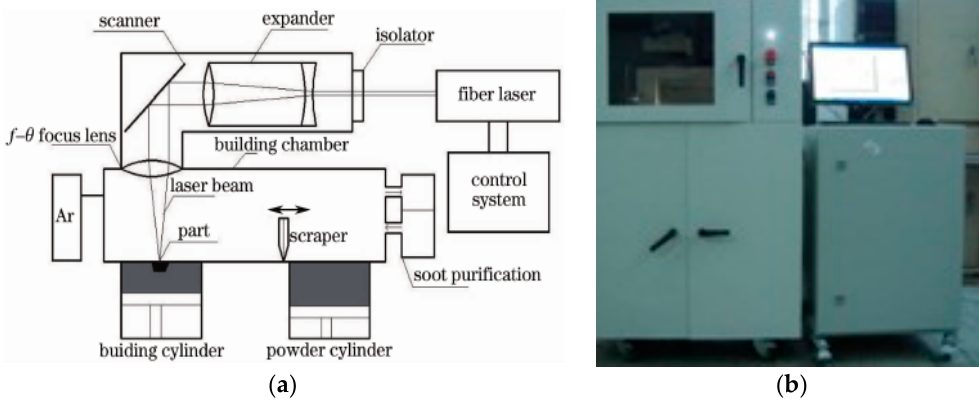
Figure 2. Principle of SLM manufacturing and the experimental DiMetal-100 equipment. ( a ) Principle of SLM manufacturing; and ( b ) DiMetal-100.